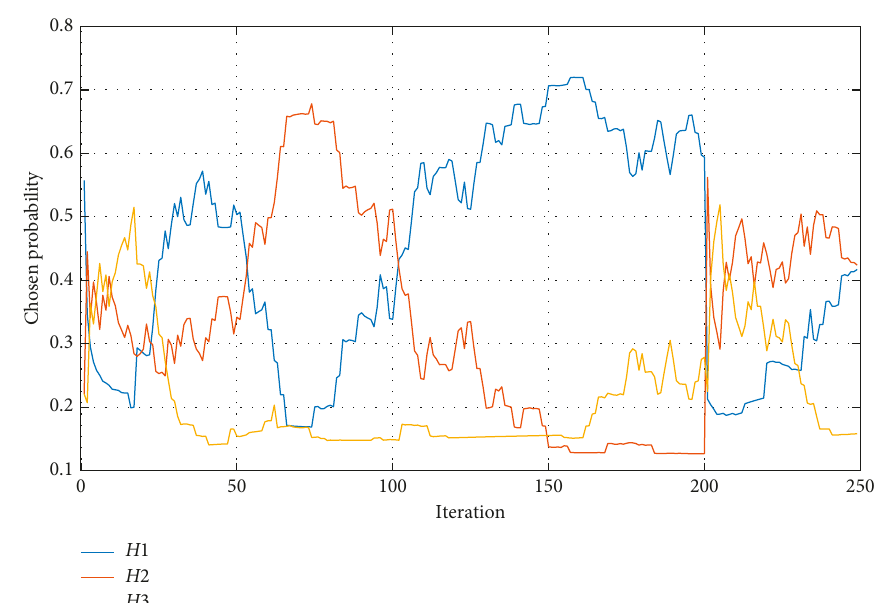
Figure 7: Effect of ES on load